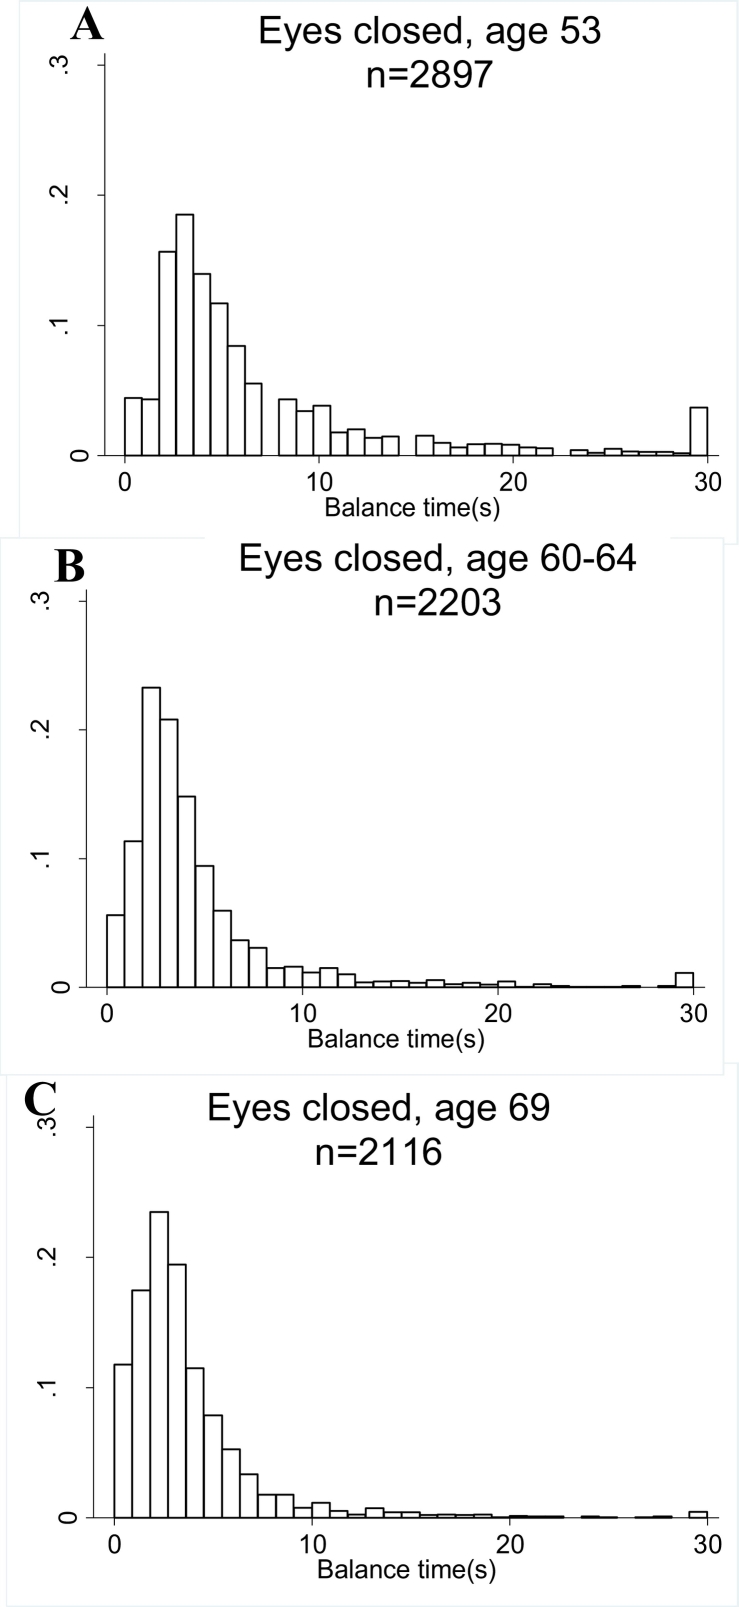
Distribution of balance times among maximal sample at ages 53, 60–64 and 69 years.